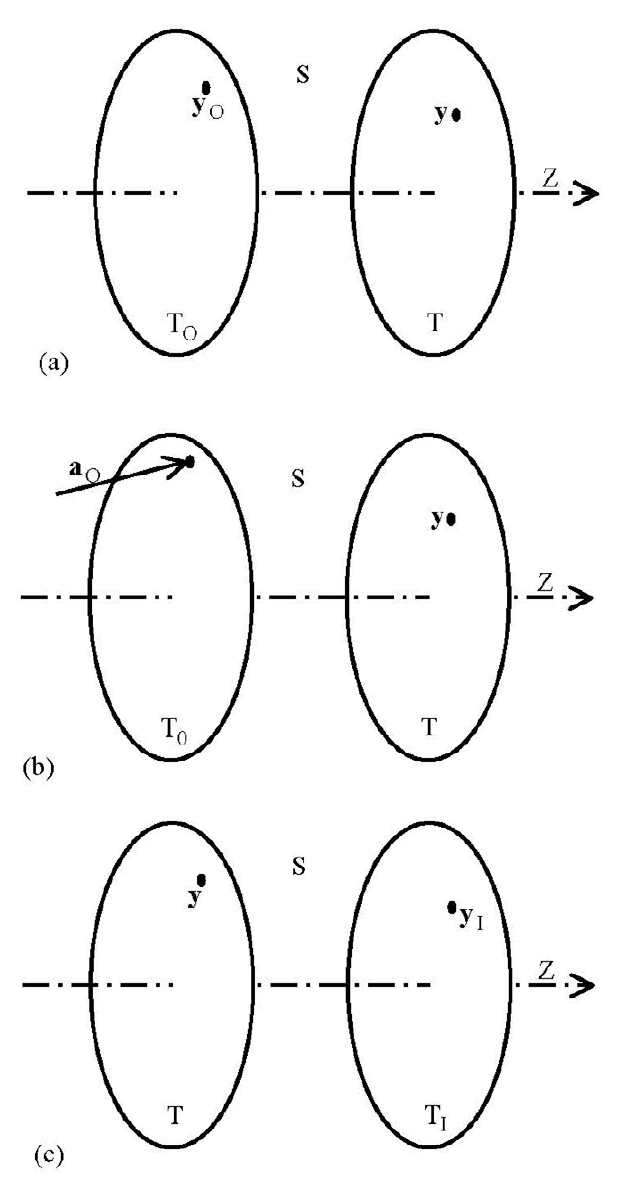
with respect to Z and is O of S. A ray (not shown) from O and from O 0 on exit plane T . In (d) a I I with inclination a on its way to a 0 I